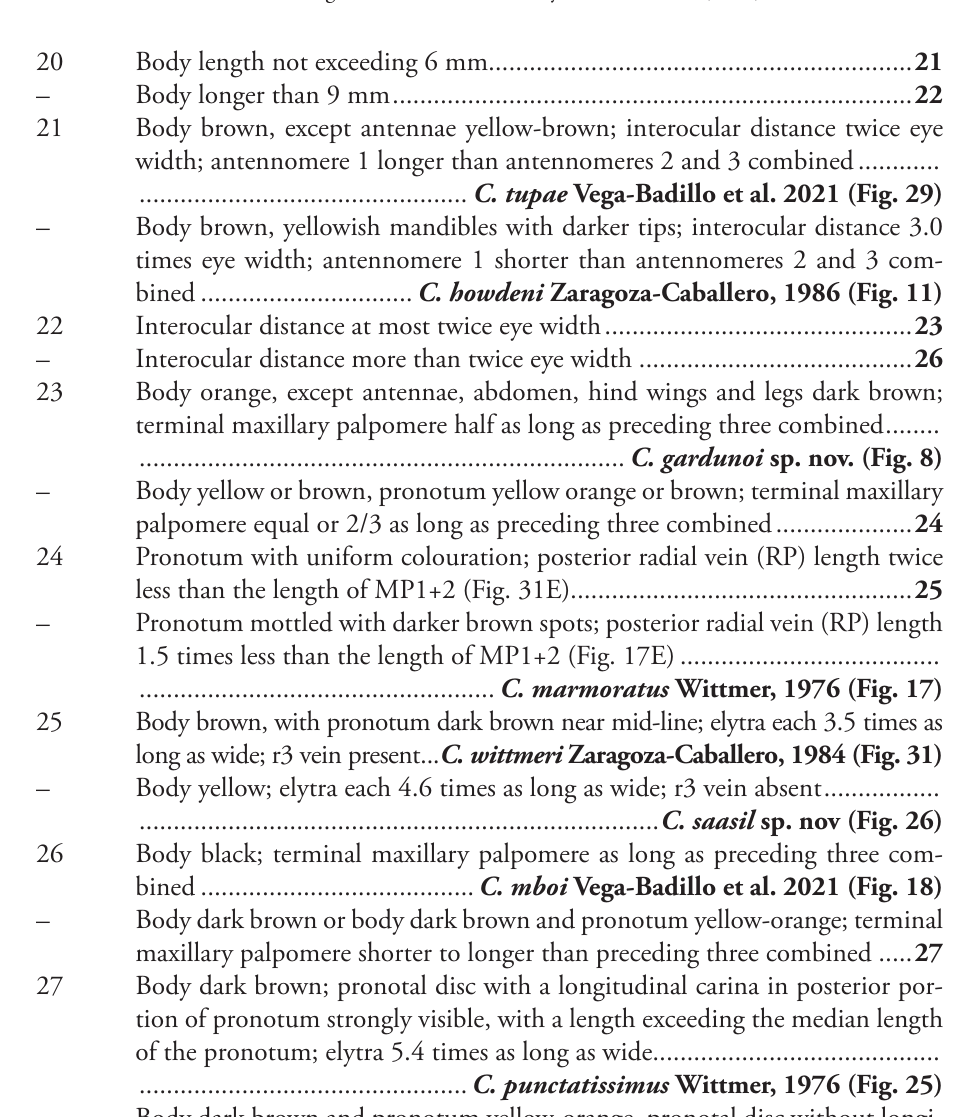
– 21 Body brown, except antennae yellow-brown; interocular distance twice eye width; antennomere 1 longer than antennomeres 2 and 3 combined ............ – Body brown, yellowish mandibles with darker tips; interocular distance 3.0 times eye width; antennomere 1 shorter than antennomeres 2 and 3 com- 22 – Interocular distance more than twice eye width ........................................ 26 23 Body orange, except antennae, abdomen, hind wings and legs dark brown; terminal maxillary palpomere half as long as preceding three combined ........ – Body yellow or brown, pronotum yellow orange or brown; terminal maxillary palpomere equal or 2/3 as long as preceding three combined .................... 24 24 Pronotum with uniform colouration; posterior radial vein (RP) length twice less than the length of MP1+2 (Fig. 31E).................................................. 25 – Pronotum mottled with darker brown spots; posterior radial vein (RP) length 1.5 times less than the length of MP1+2 (Fig. 17E) ...................................... 25 Body brown, with pronotum dark brown near mid-line; elytra each 3.5 times as long as wide; r3 vein present ... C. wittmeri Zaragoza-Caballero, 1984 (Fig. 31) – Body yellow; elytra each 4.6 times as long as wide; r3 vein absent ................. 26 Body black; terminal maxillary palpomere as long as preceding three com- – Body dark brown or body dark brown and pronotum yellow-orange; terminal maxillary palpomere shorter to longer than preceding three combined ..... 27 27 Body dark brown; pronotal disc with a longitudinal carina in posterior por- tion of pronotum strongly visible, with a length exceeding the median length of the pronotum; elytra 5.4 times as long as wide.......................................... – Body dark brown and pronotum yellow-orange, pronotal disc without longi- tudinal carina; each elytron less than 5.0 times as long as wide ................. 28 28 Antennomere 1 as long as antennomeres 2 and 3 combined; terminal maxil- lary palpomere longer than preceding three combined .................................. – Antennomere 1 is longer than antennomeres 2 and 3 combined; terminal maxillary palpomere shorter than or equal to preceding three combined ... 29 29 Terminal maxillary palpomere shorter than preceding three combined; anten- nal rami 1.5 times respective antennomere ........ C. zuritai sp. nov. (Fig. 33) – Terminal maxillary palpomere as long as preceding three combined;